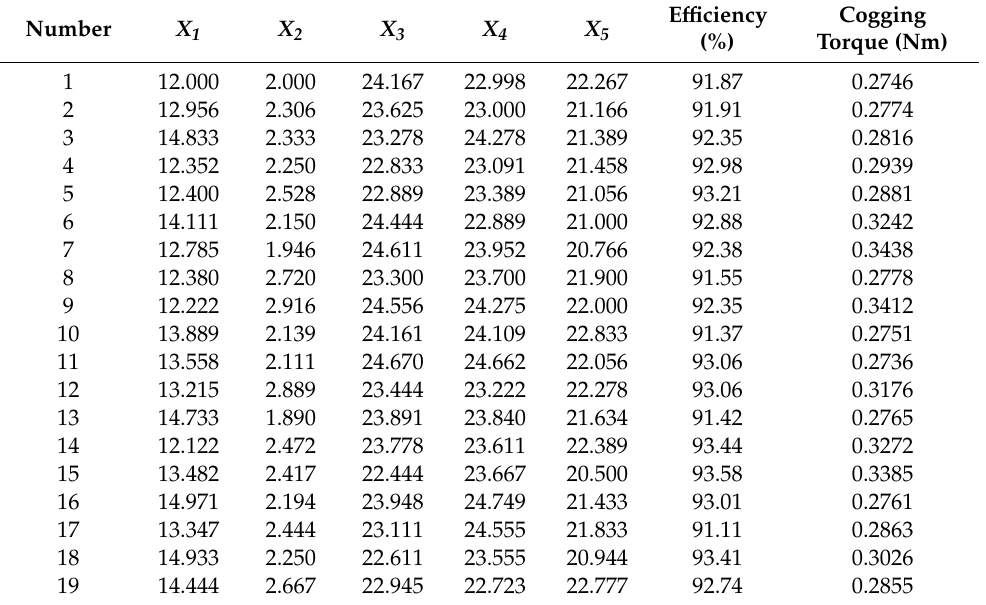
Table A1. Characteristics of samples obtained from optimal Latin hypercube design (OLHD) using finite element (FE)